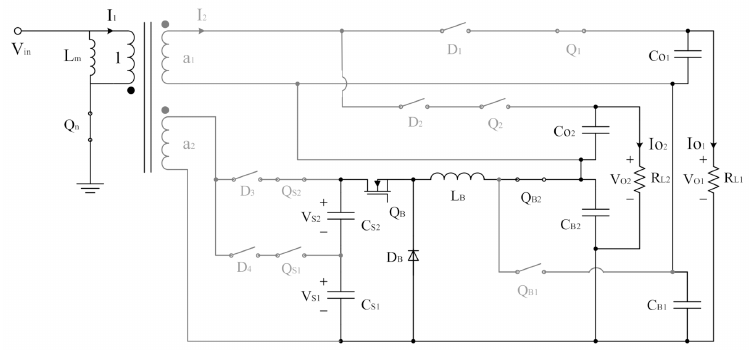
Figure 5. Equivalent circuits of the proposed SIMO power supply within